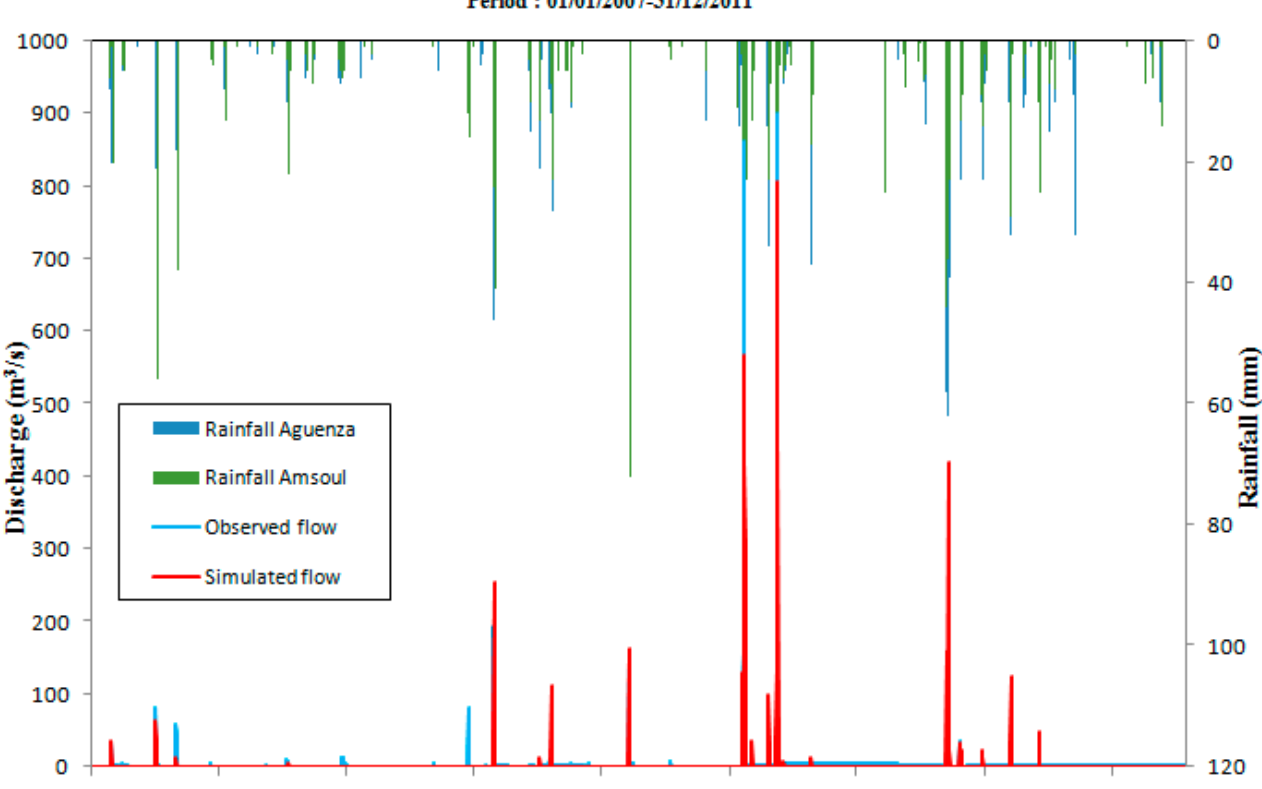
Figure 9. Illustration of the GR4J model output visualization during the period used for valida- tion”2007–2011”.